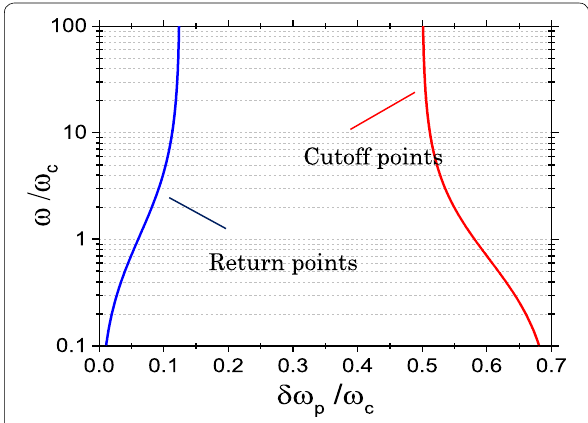
Fig. 6 The blue curve is related to the plasma frequency demand in the occurrence of efficient mode conversion processes .